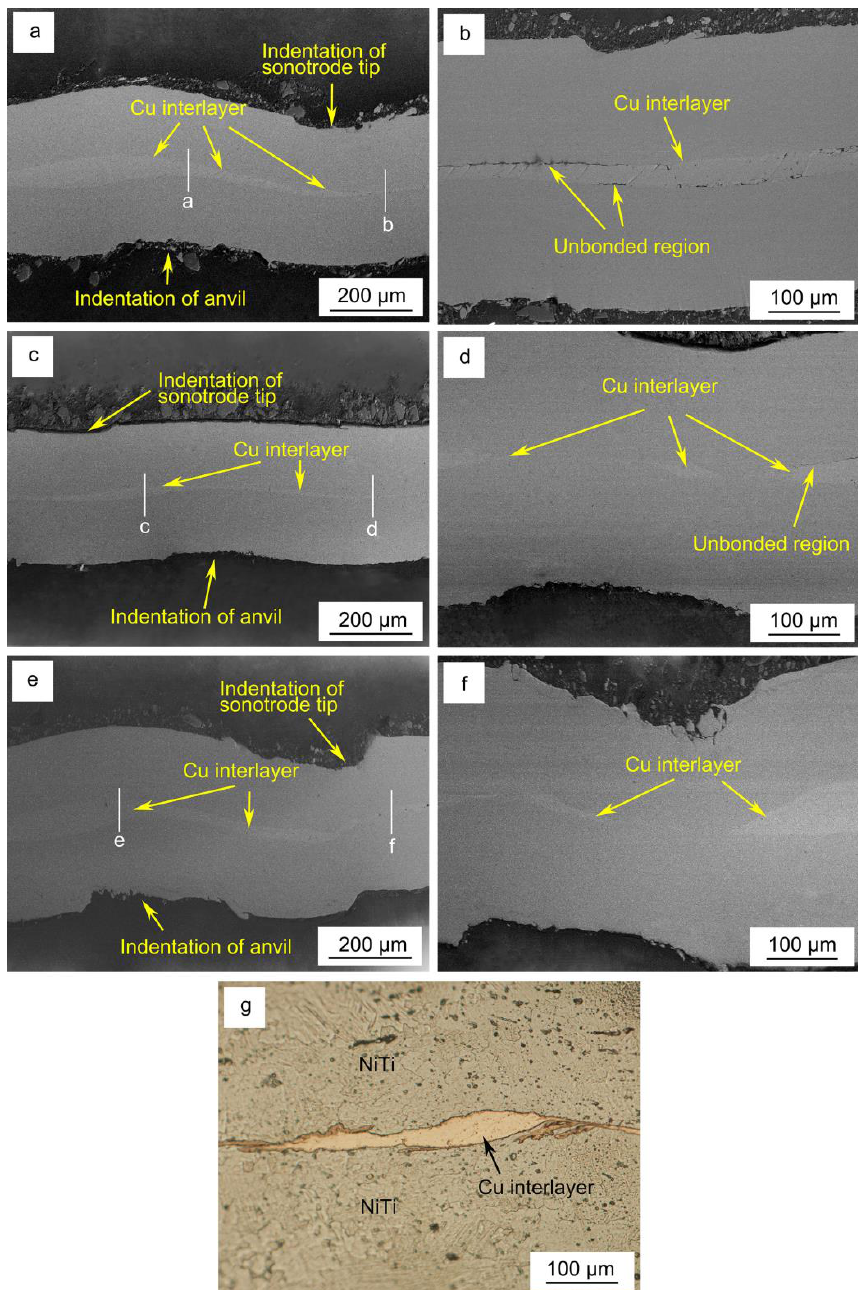
Figure 4. ( a , b ) interface morphology of the welded joint obtained at 500 J at the center ( a ) and near the periphery ( b ) of the joint; ( c , d ) interface morphology of the welded joint obtained at 700 J at the center ( c ) and near the periphery ( d ) of the joint; ( e , f ): interface morphology of the welded joint obtained at 1000 J at the center ( e ) and near the periphery ( f ) of the joint; ( g ) microstructure interface of weld of 1000 J obtained by optical microscope. The white lines in Figure 4. ( a , c , e ) represent the locals where EDS line scans were performed.